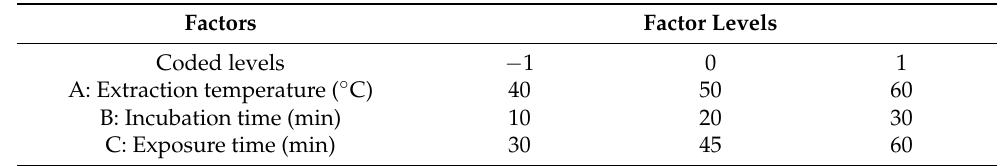
Table 6. Independent factors and their levels used in the BBD for optimization of SPME Arrow extraction for determination of bound volatile compounds.